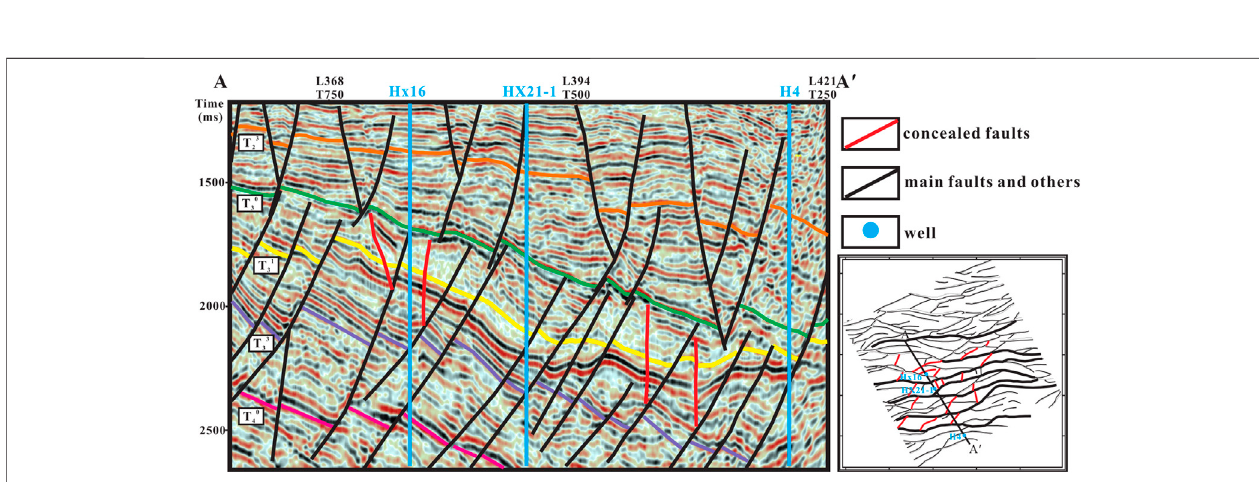
FIGURE 4 | (A) seismic cross-section with some well-logs, multiple horizons, including T 31 and others, main faults, and concealed faults.